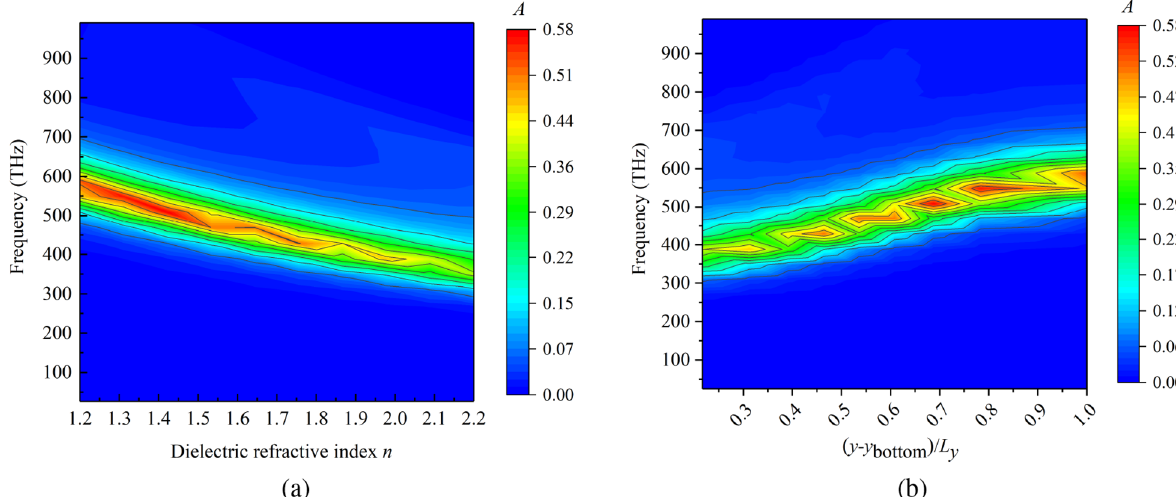
Fig. 5. (a) 2D color contour plot for the absorptance ( A ) as a function of frequency f and surrounding refractive index n , for the single- rod case shown in Figure 2a. (b) 2D color contour plot for the absorptance ( A ) as a function of frequency f and relative vertical position ( y (cid:2) y bottom / L y ) in the case where the single rhodium rod of radius 14nm is placed at a vertical position y in a graded index slab of thickness L y , bottom surface at y bottom , and index variation between 1.2 and